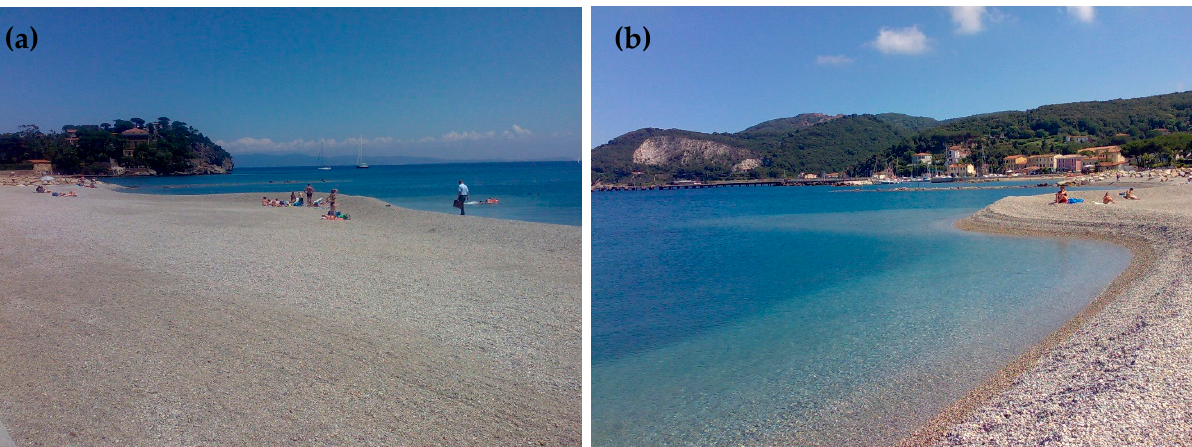
Figure 10. Storm berm crest on the Northern Cell, October 2018 (Google Earth). Beach volume increase on the dry beach and decrease on the wet one in the 2007– 2018 period can be explained with the onshore sand moving, very likely induced by the higher permeability and porosity of the gravel fill, as observed in other gravel nourish- ments [21]. Similar to what was observed by previous authors, sand patches are seldom present in the swash zone and sand saturates the pores of the gravel as evident in some trenches excavated on the berm.